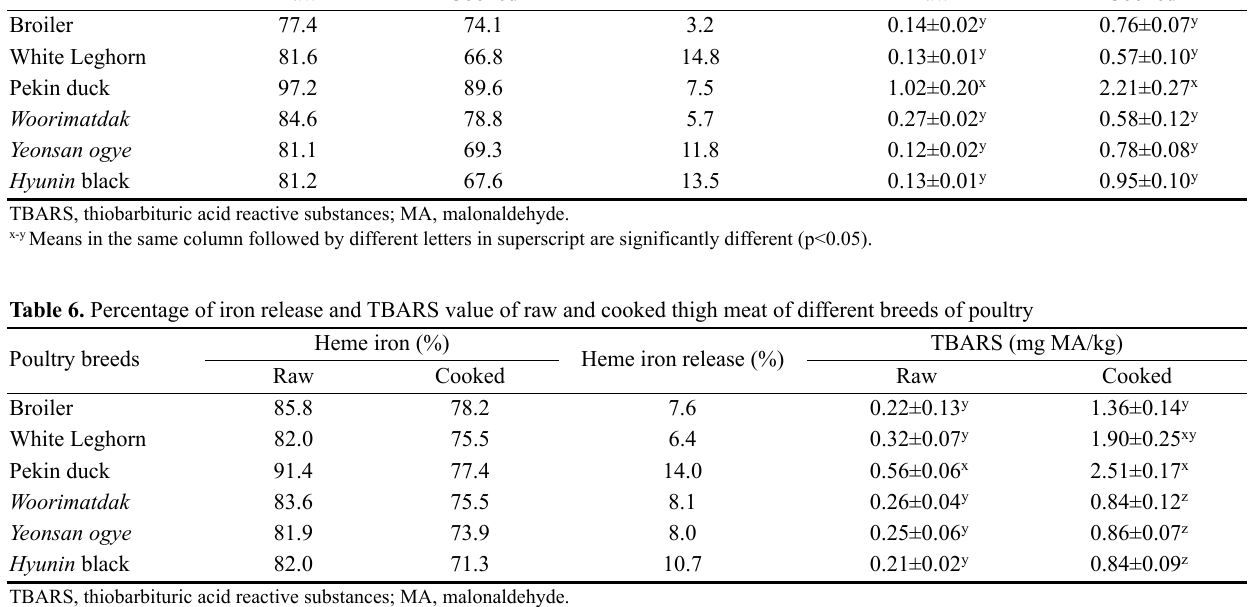
Table 5. Percentage of iron release and TBARS value of raw and cooked breast meat of different breeds of poultry Heme iron (%) Poultry breeds